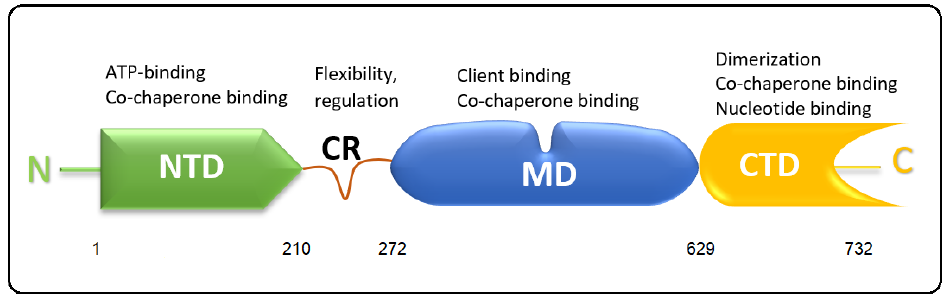
Figure 2. A schematic representation of the Hsp90 domain structure. NTD, N-terminal domain; CR, charged linker region; MD, middle domain; CTD, C-terminal domain. Numbers indicate the amino acids at the domain boundaries.